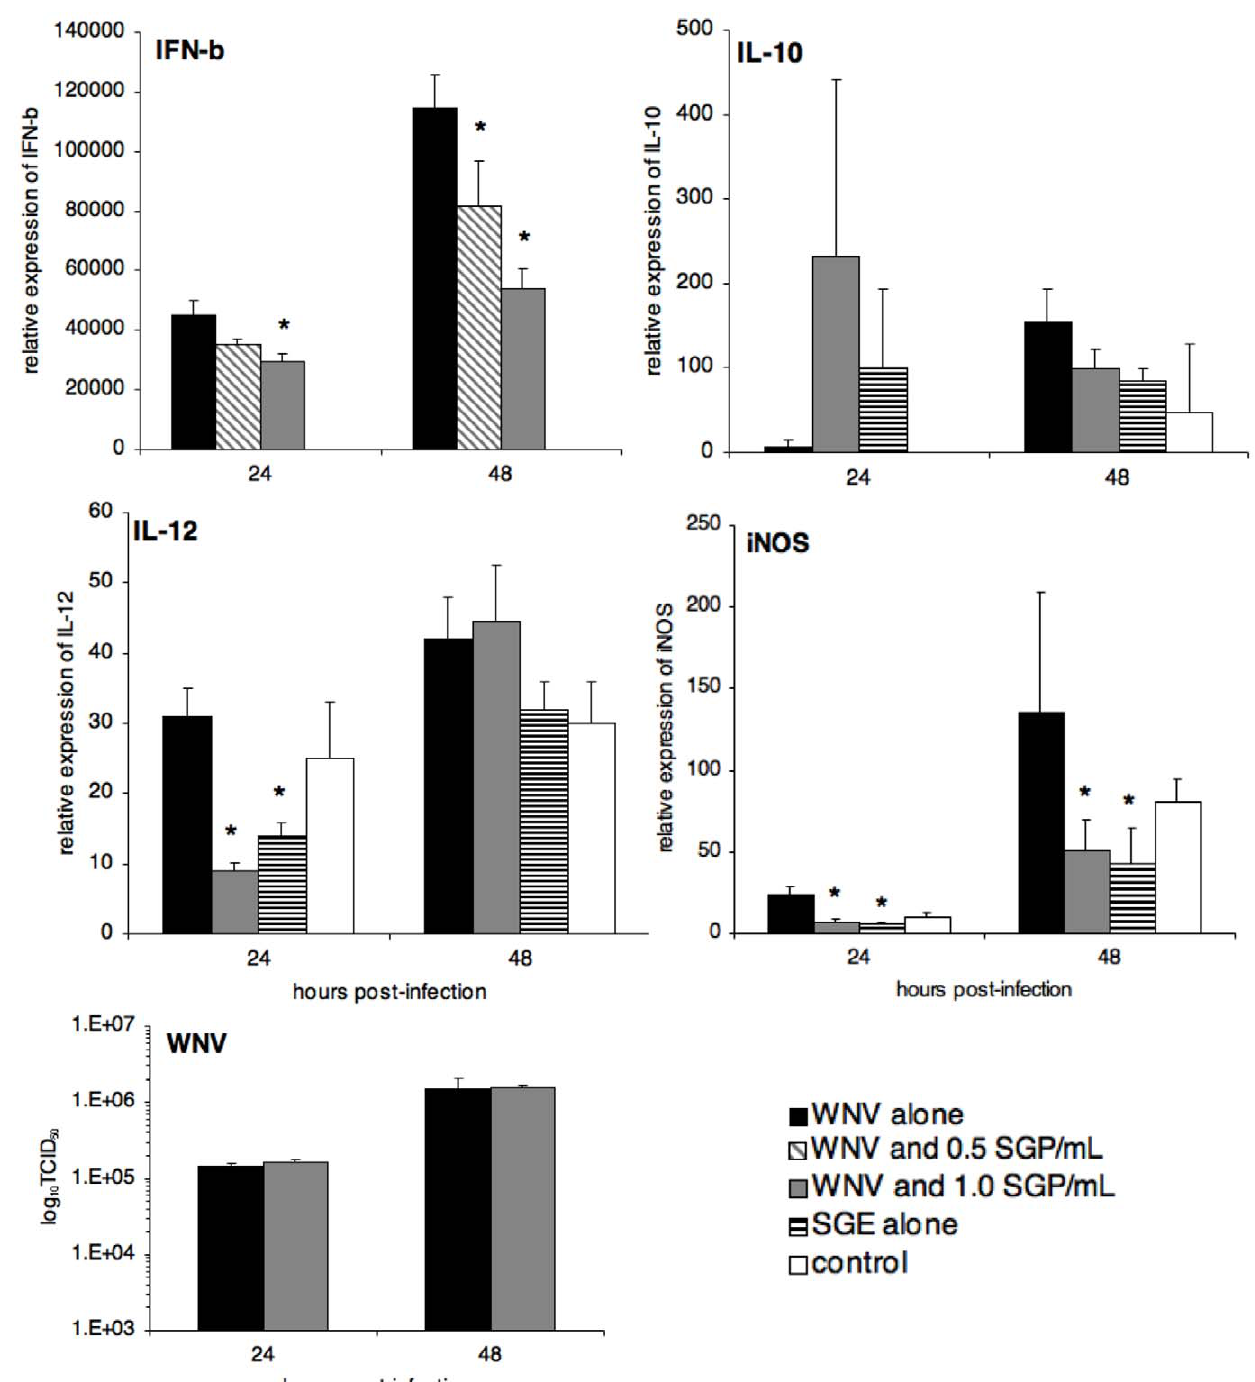
Figure 1. Cytokine expression and WNV titers in resident peritoneal macrophages following invitro infection in the presence mosquito salivary gland extract (SGE). IFN- b , IL-10, IL-12, and iNOS levels were assessed by real-time RT-PCR at 24 and 48 h post-infection (MOI=5). Their mRNA expression levels were normalized to those of the GAPDH gene. WNV production was quantified by titration on vero cells. The means 6 standard deviation are shown, and an asterisk signifies a statistically significant difference (p , 0.05) as compared to the group infected with WNV alone as determined by Mann-Whitney test. IFN- c and IL-1 b mRNA expression were found not to vary among groups (data not shown). Control groups were mock infected with PBS alone. Results were similar in three independent replicates.